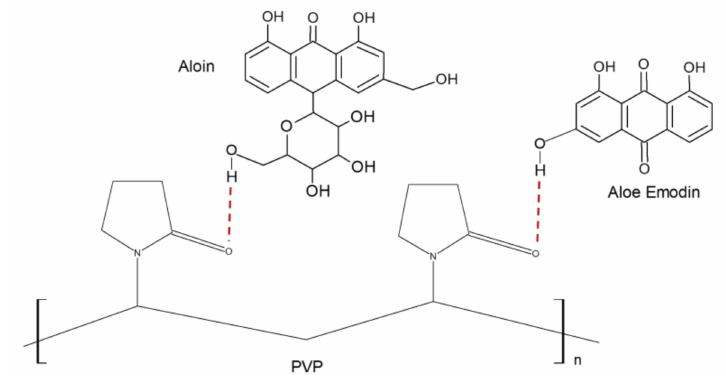
Figure 10. Scheme of hydrogen bonding between Aloe vera (AV) components with the examples Aloin and Aloe Emodin with polyvinylpyrrolidone